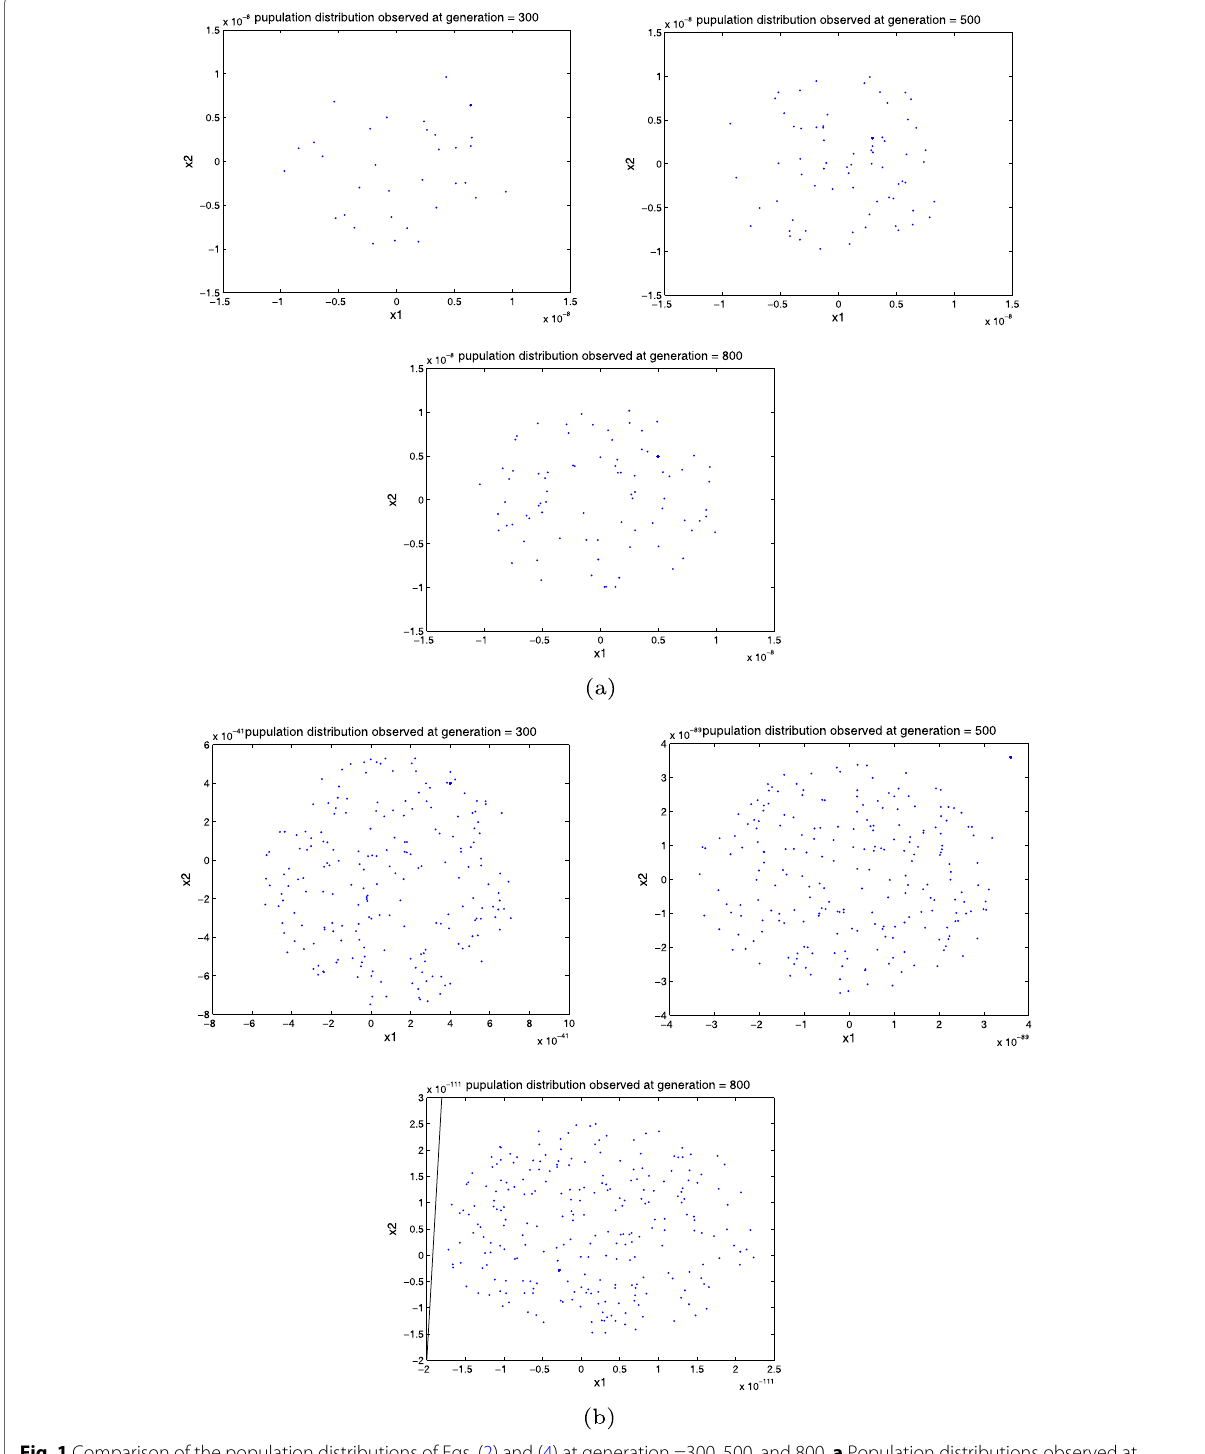
Fig. 1 Comparison of the population distributions of Eqs. (2) and (4) at generation =300, 500, and 800. a Population distributions observed at generation = 300, 500, and 800 in Eq. (2). b Population distributions observed at generation = 300, 500, and 800 in Eq.